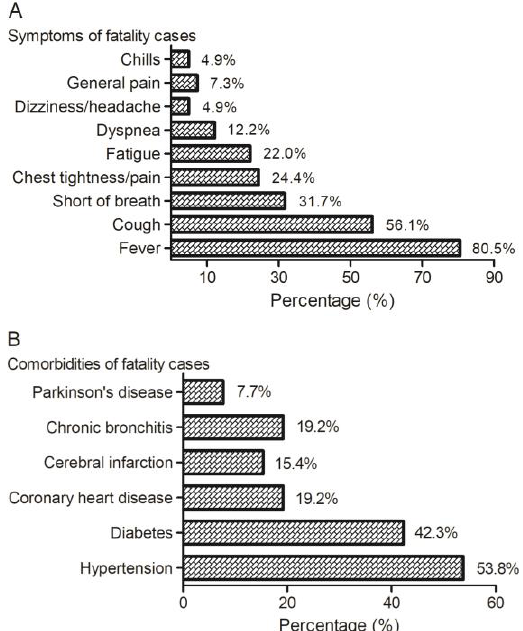
Figure 2. Clinical symptoms and comorbidities of the patients died of COVID-19. ( A ) Among 41 cases with fatalities, the symptoms include fever (80.5%), cough (56.1%), shortness of breath (31.7%), chest tightness / pain (24.4%), fatigue (22.0%), dyspnea (12.2%), dizziness / headache (4.9%), general pain (7.3%), and chills (4.9%). ( B ) Among 26 cases with fatalities, the major comorbidities are hypertension (53.8%), diabetes (42.3%), coronary heart disease (19.2%), cerebral infarction (15.4%), chronic bronchitis (19.2%), and Parkinson’s disease (7.7%). The case information is from reports